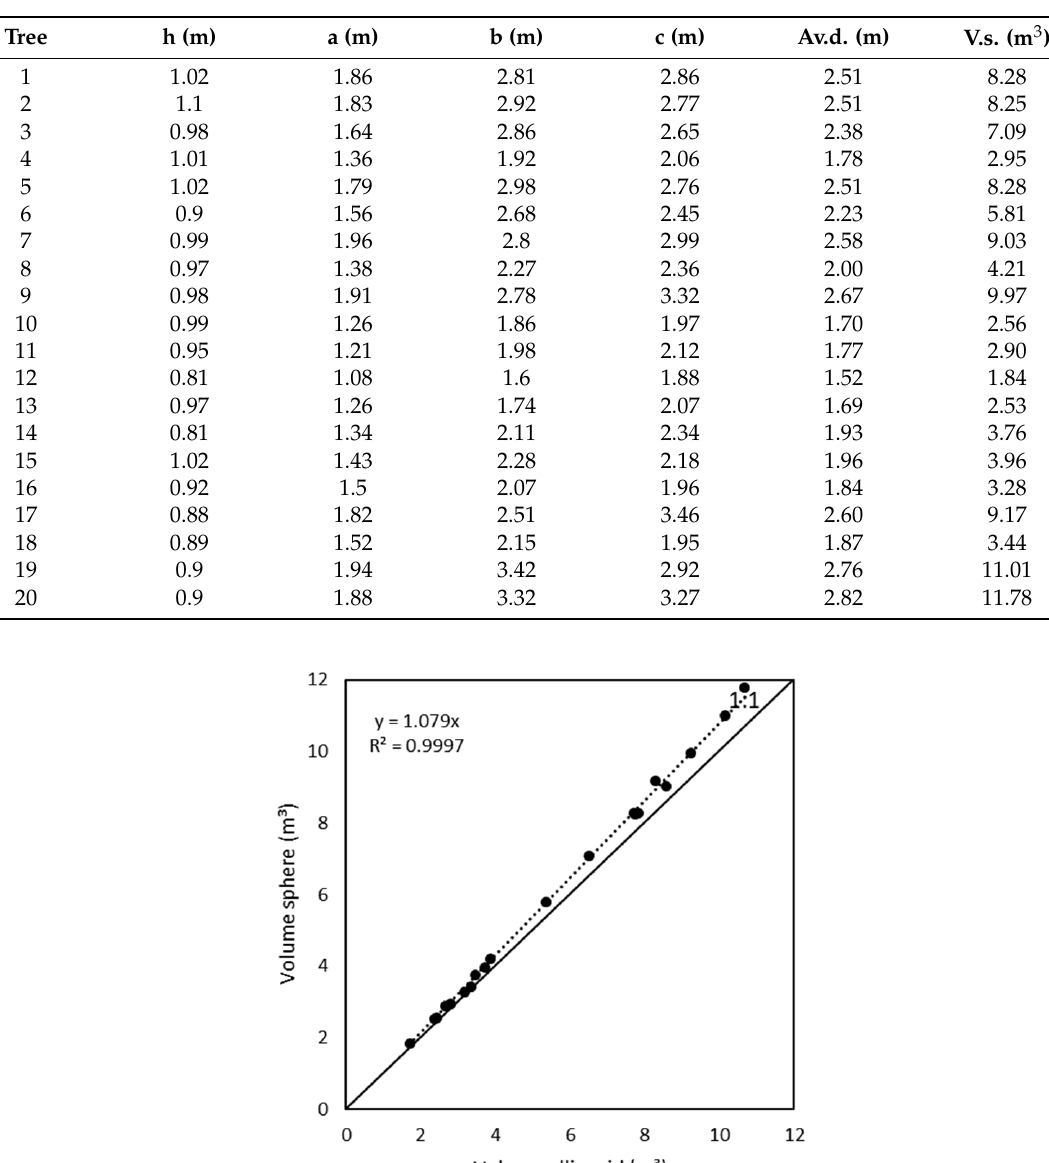
15 of 23 Table 2. Ground-truth values. h: distance from the canopy to the ground; a: height; b: length; c: width; Av.d.: Average diameter (m); V.s.: Volume of the sphere (m³); V.e.: Volume of the ellipsoid